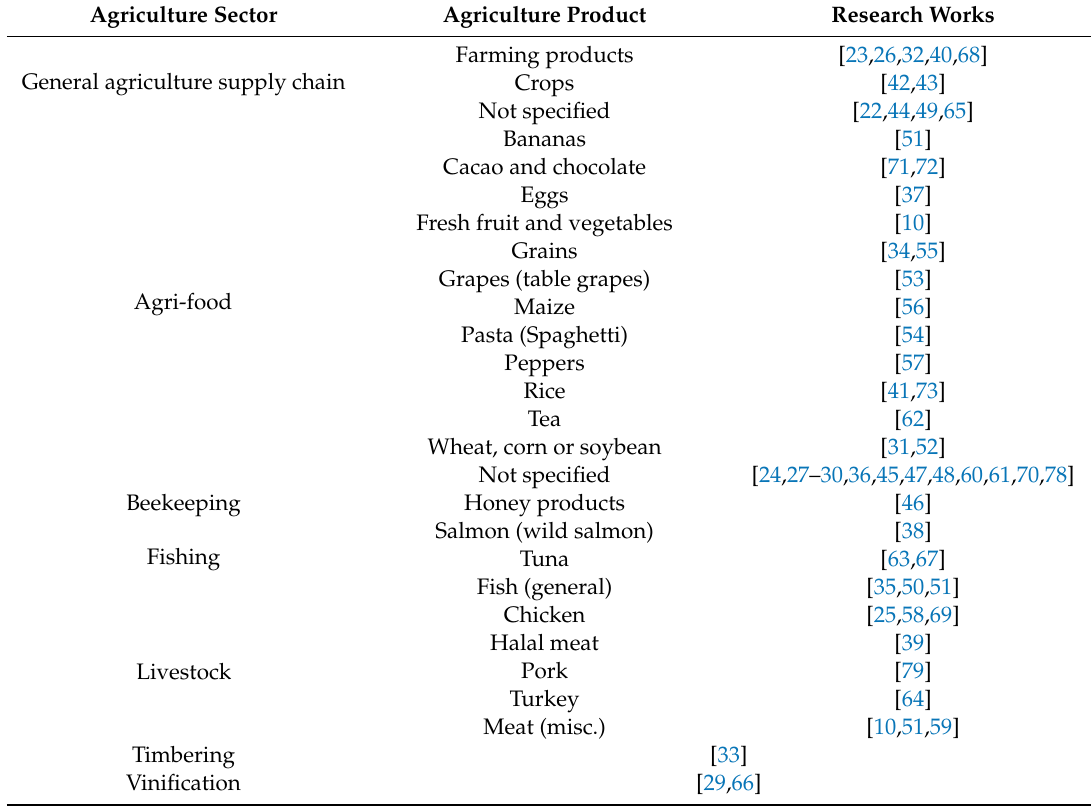
Table 3. Applications of blockchain technology for traceability across di ff erent agriculture sectors and